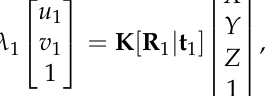
corresponding to the spatial point M can be 1 m